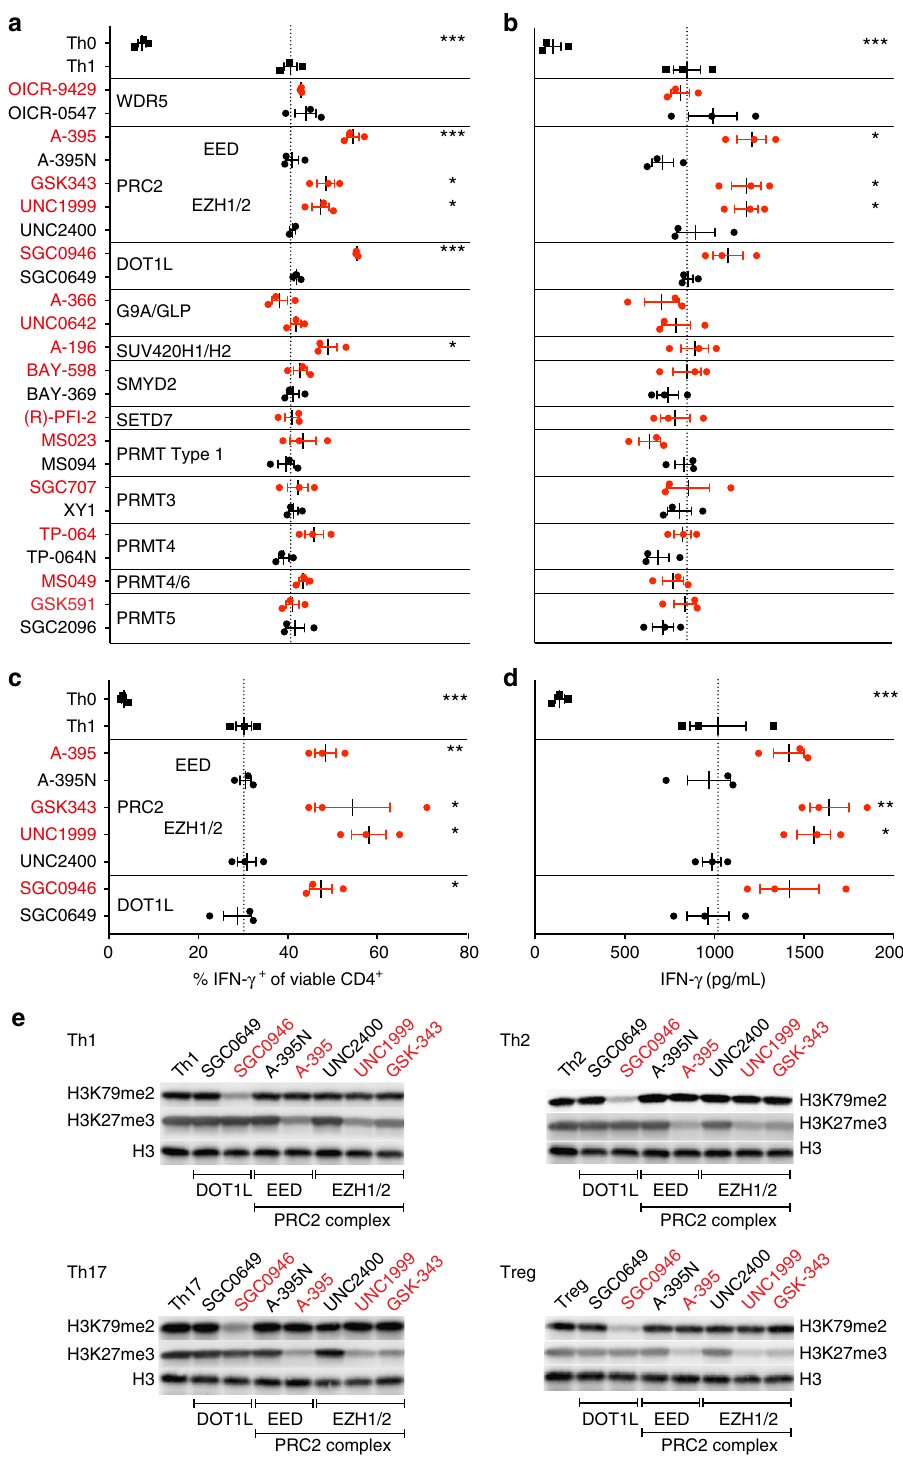
T cells using A-395 (but not A-395N), an antagonist of the EED subunit of PRC2 which prevents the latter ’ s enzymatic activity 35 , demonstrating that the enhanced IFN- γ expression and produc- tion was independent of the chemotype of the active probe, further strengthening the link between PRC2 inhibition and Th1 cell differentiation. Our results also identi fi ed a role for the H3K79 methyltransferase DOT1L in regulation of Th1 cell differentiation. DOT1L inhibition resulted in an increase in the frequency of viable IFN- γ + CD4 + cells and higher production of